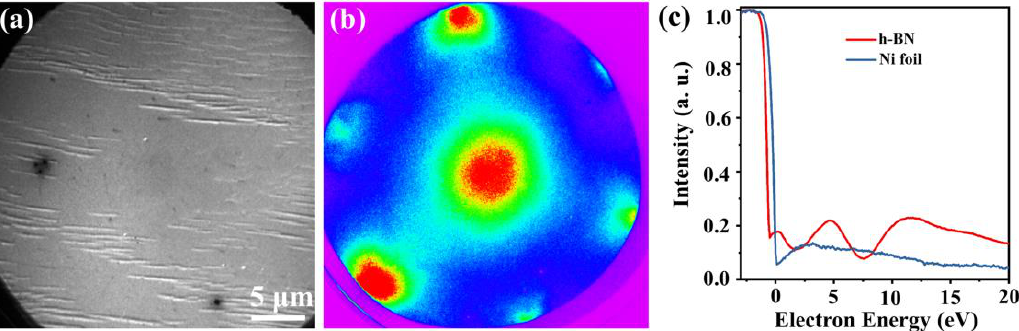
Figure 2. ( a ) LEEM image of full monolayer h-BN on the Ni substrate at 850°C. ( b ) μ-LEED pattern (50 eV) of the h-BN overlayer. ( c ) LEER spectra acquired from h-BN and Ni substrate, respectively.